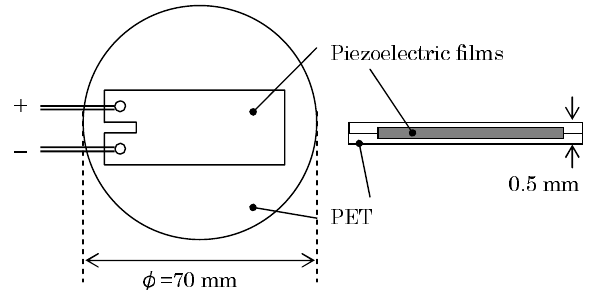
Figure 1. Design structure of prototype sensor.